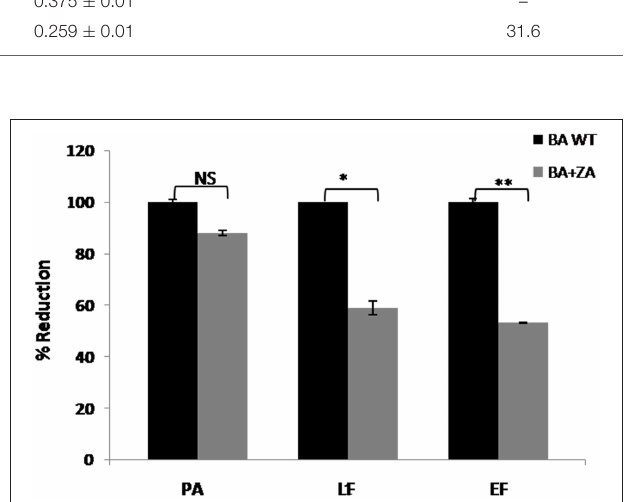
FIGURE 11 | Effect of ZA on toxin production by B. anthracis. Quantitation of major virulence factors (PA, LF, and EF) was done by ELISA. Bars represent the percent reduction of B. anthracis treated with ZA (BA+ZA) with respect to untreated cells (BA WT). NS, non-significant; * p < 0.05 and ** p <